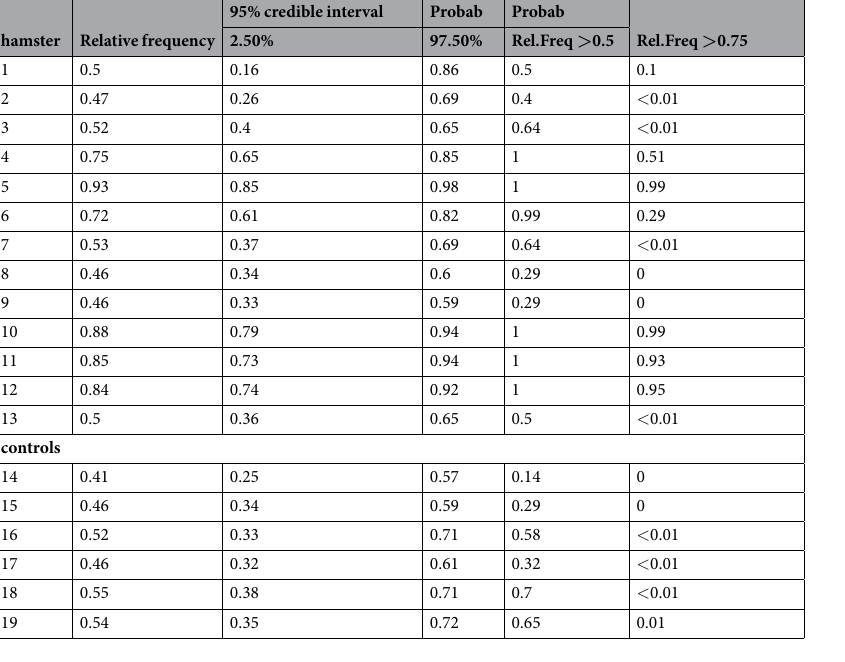
Table 2. Relative frequency is the proportion of sand flies found in the test arm (late stage infection) compared to the total number of sand flies in the test and control arm (before infection) combined. The, larger this frequency the more attractive the hamster odour is to sand flies. Credible interval is calculated on the posterior distributions (Supplementary Fig. S1) of the relative frequency of each hamster as result of accounting for uncertainty in the test parameters. The probability that the relative frequency is larger than 50 and 75% is reported in the last 2